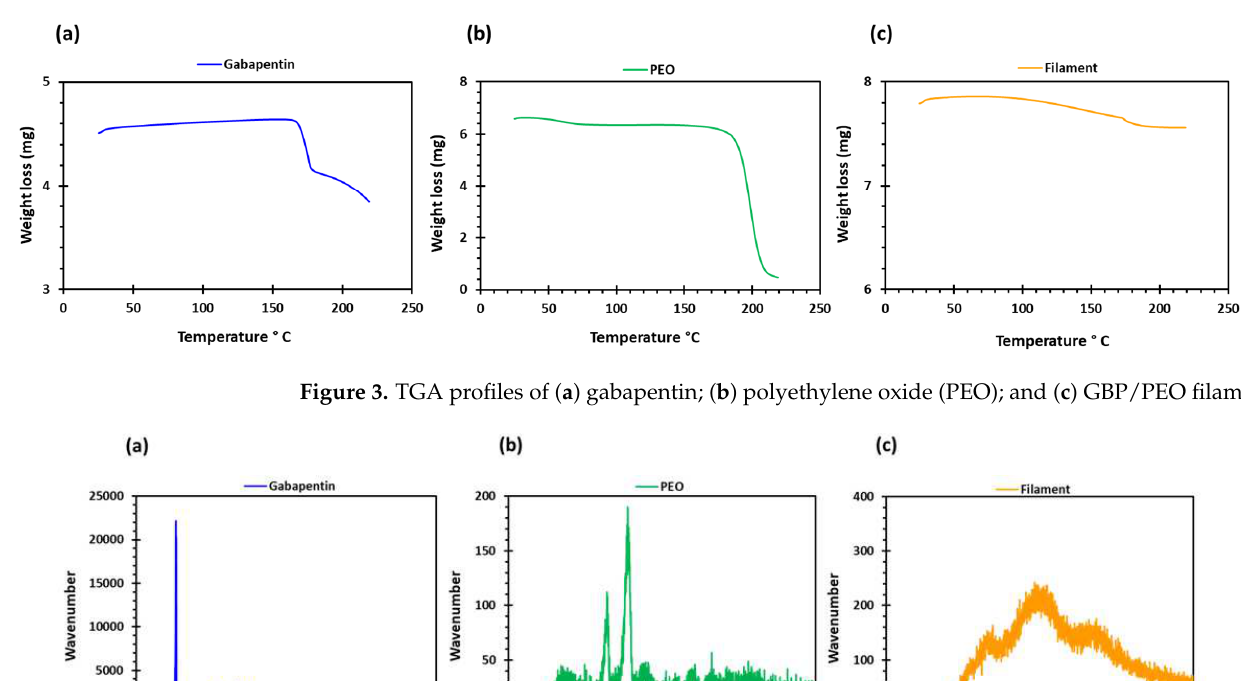
Figure 2. DSC profiles of ( a ) gabapentin; ( b ) polyethylene oxide (PEO); and ( c ) GBP/PEO filament.